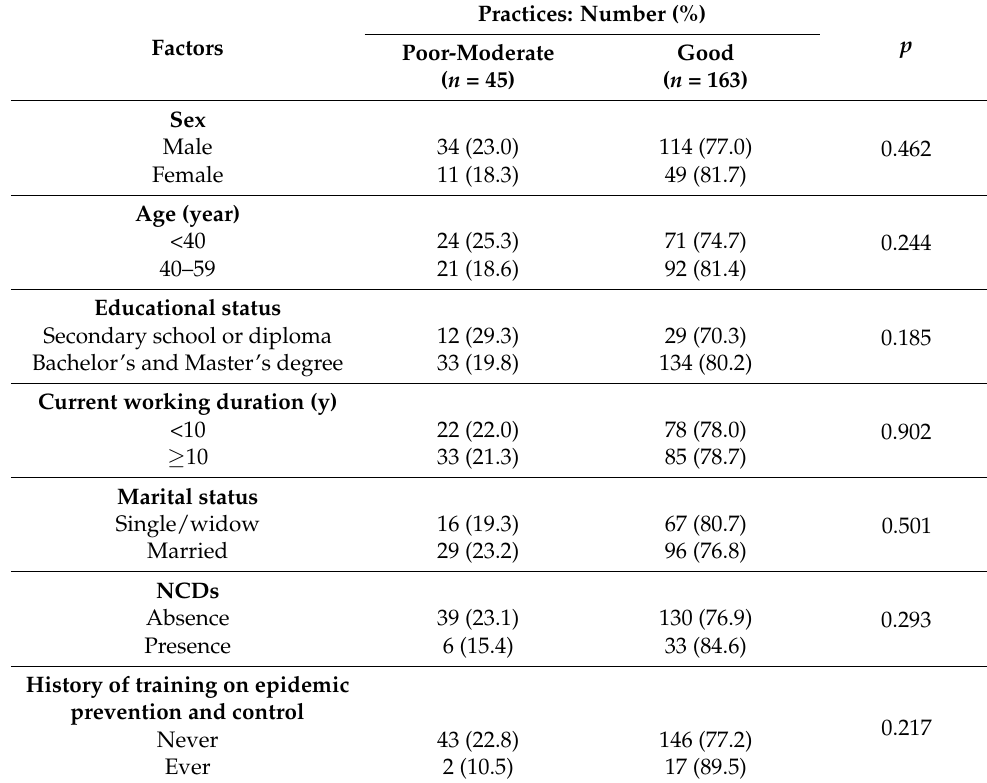
Table 4. The bivariate association between TB prevention and control practices and demographic and HL